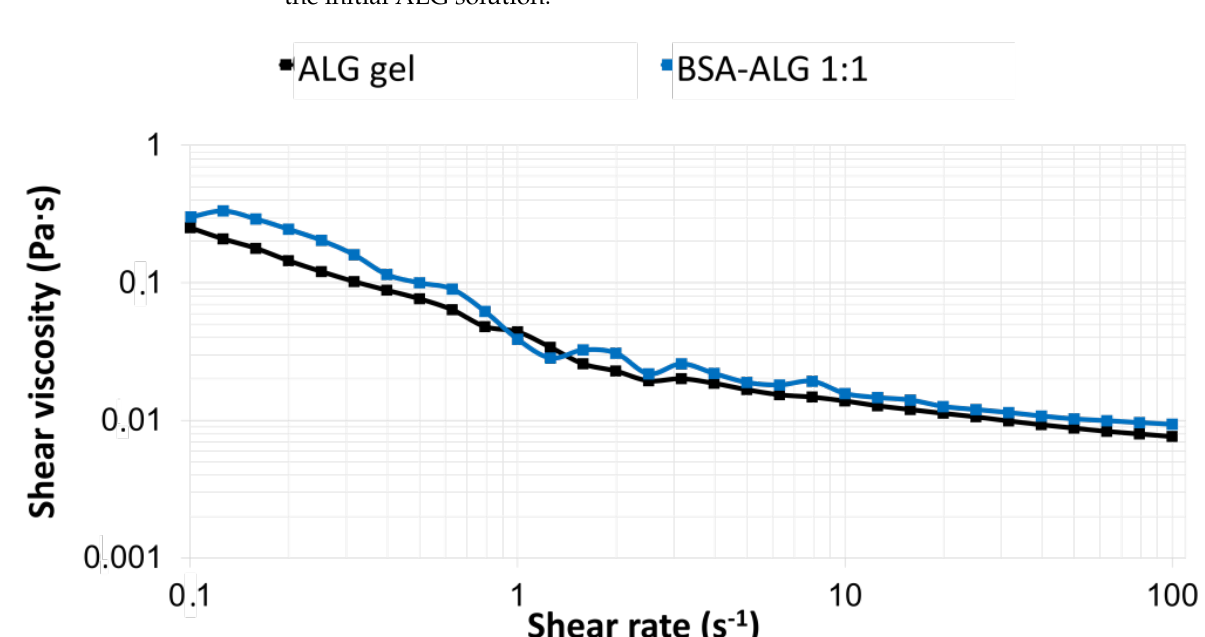
Figure 3. Flow curves contained viscosity (Pa · s) vs. shear rate (s − 1 ) of alginate samples before (black line) and after conjugation (blue line).